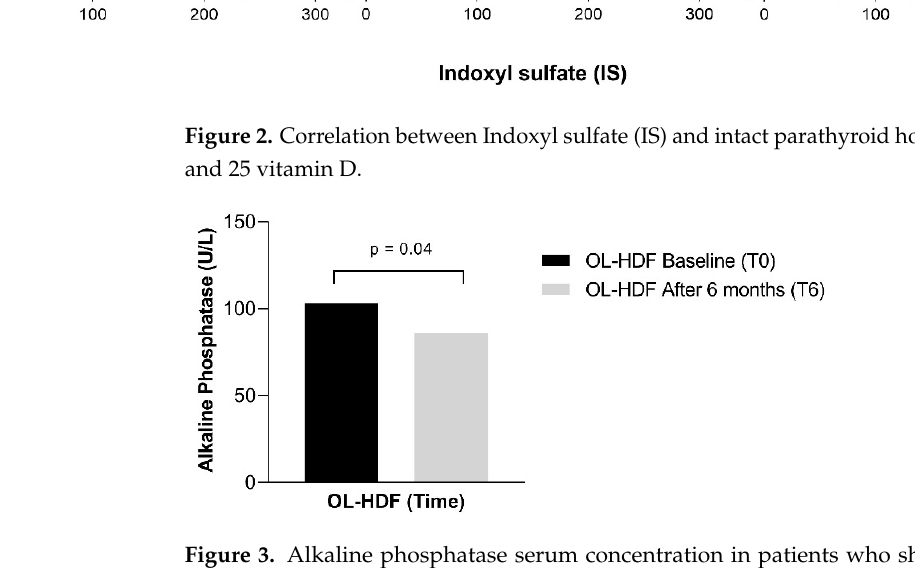
Figure 2. Correlation between Indoxyl sulfate (IS) and intact parathyroid hormone (iPTH), phos- phate and 25 vitamin D.